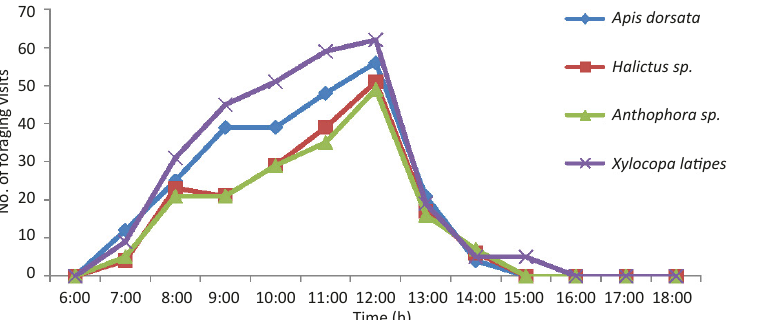
Figure 1. Hourly foraging activity of bees on Eriolaena hookeriana (average of foraging visits recorded on three different days Tirumala and Ananthagiri sites in 2011 and 2012